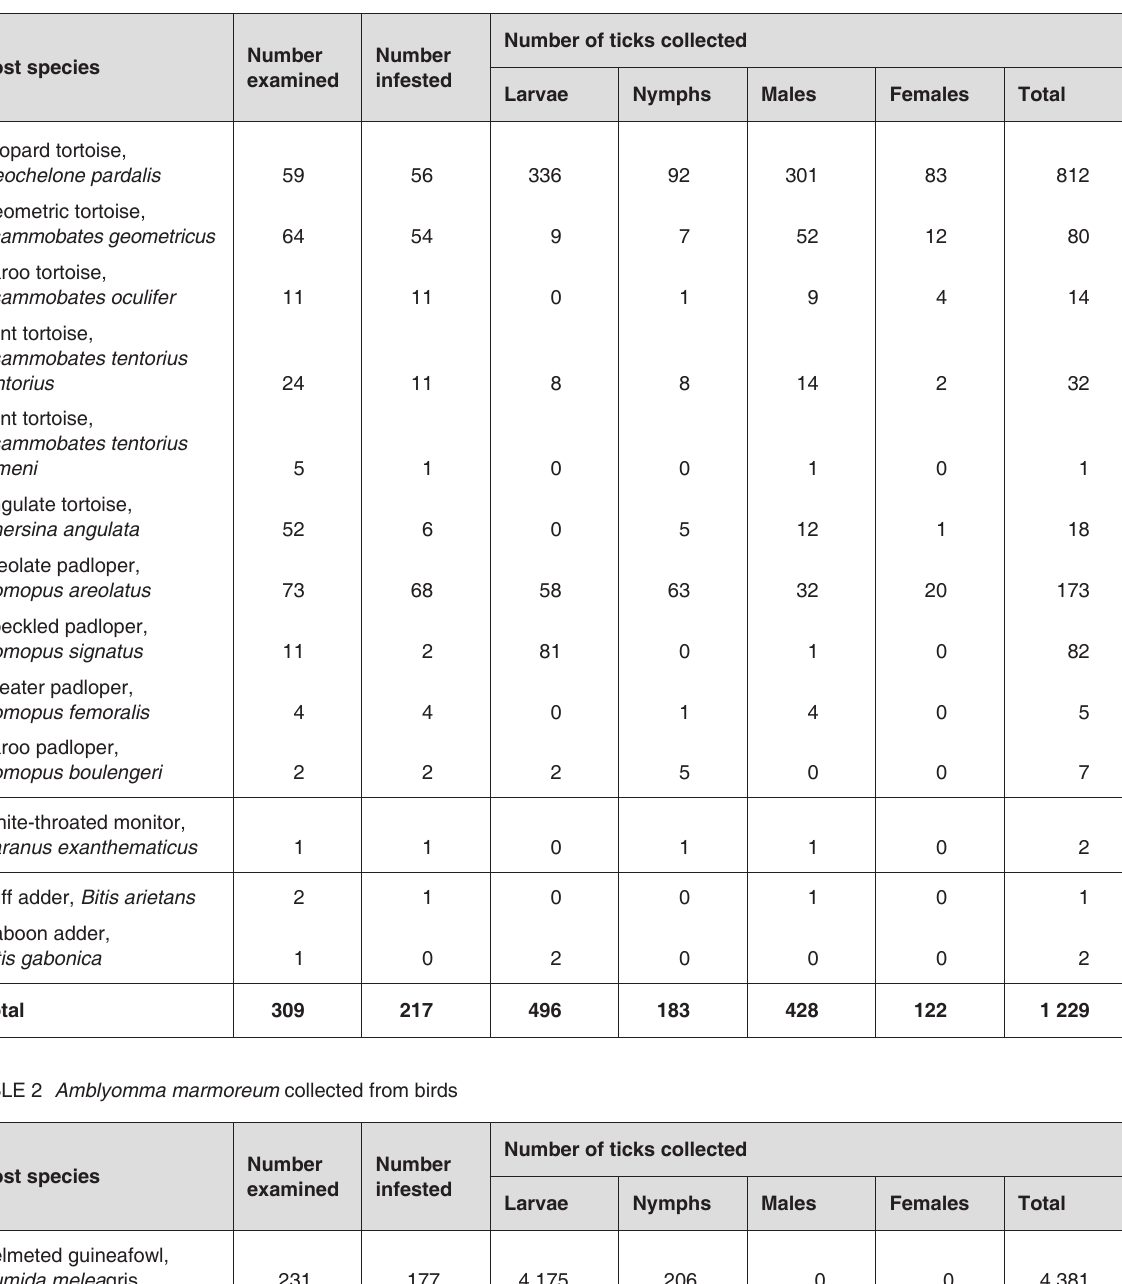
TABLE 1 Amblyomma marmoreum collected from reptiles